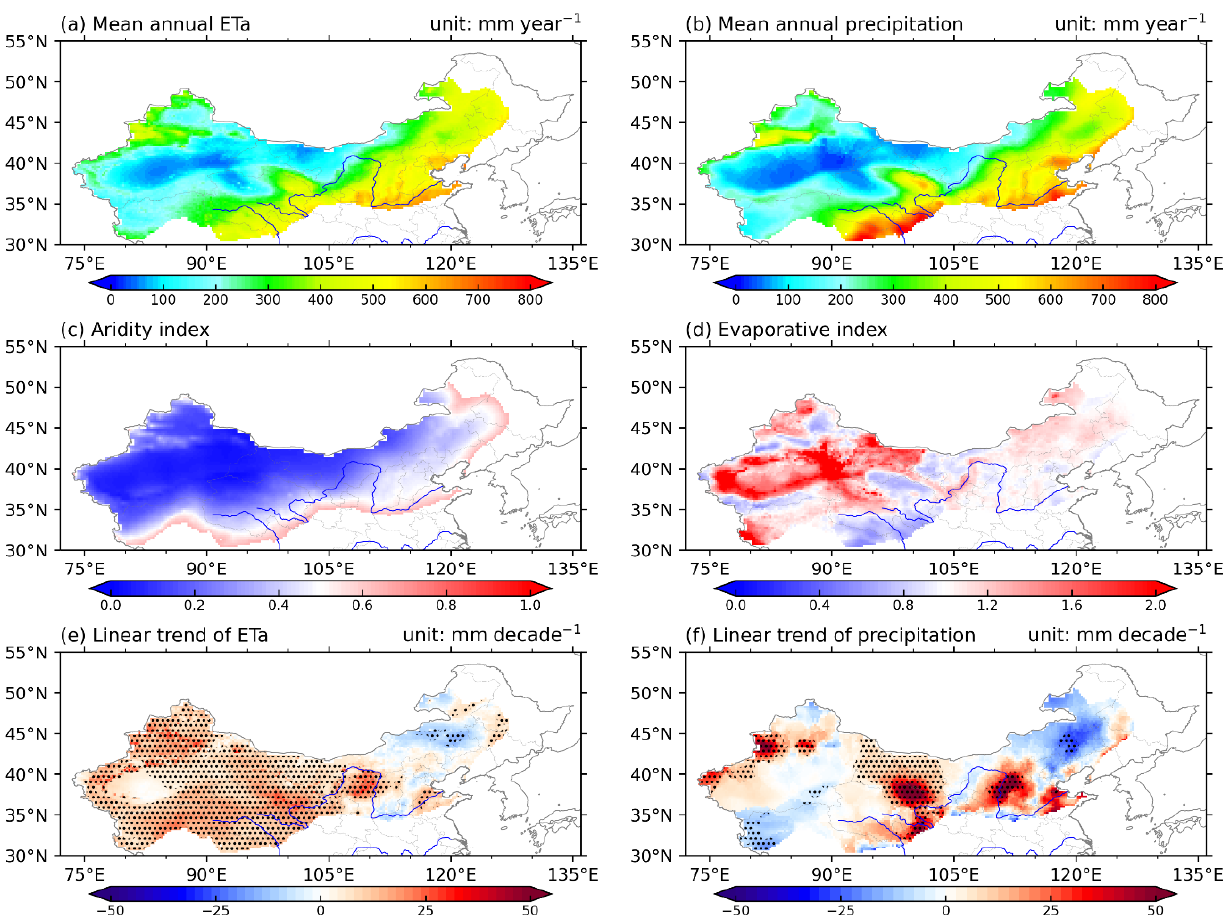
Figure 2. Long-term mean annual ( a ) ETa, ( b ) precipitation (unit: mm·year − 1 ), ( c ) aridity index ( AI ), and ( d ) evaporative index in northern China (AI < 0.65). ( e ) and ( f ) show the linear trends of ETa and precipitation during 1982–2017 (unit: mm·decade − 1 ), respectively. The dots in ( e ) and ( f ) denote values exceeding the 95% confidence level.